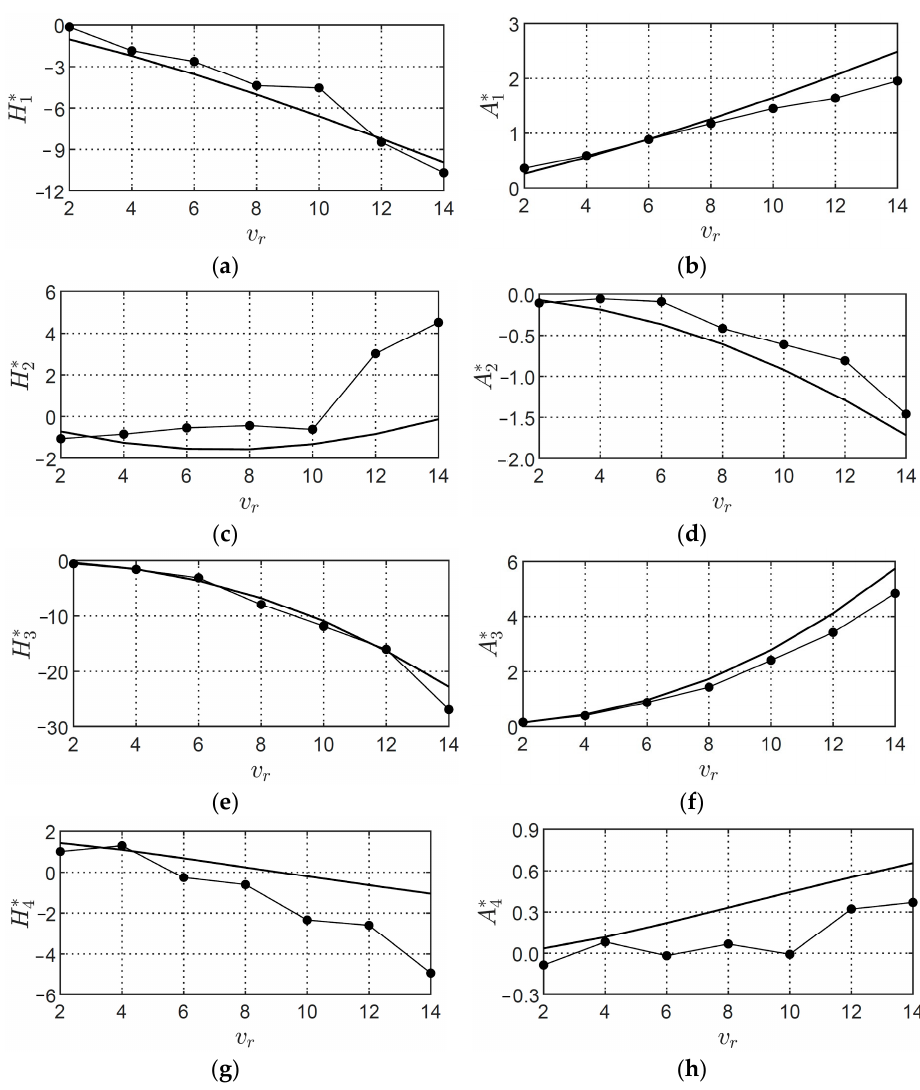
Figure 29. Aerodynamics derivatives from CFD simulation. ( ‒●‒ ) CFD forced vibration analysis, ( ― ) fl at plate by Theodorsen. ( a ) 𝐻 (cid:2869)∗ ; ( b ) 𝐴 (cid:2869)∗ ; ( c ) 𝐻 (cid:2870)∗ ; ( d ) 𝐴 (cid:2870)∗ ; ( e ) 𝐻 (cid:2871)∗ ; ( f ) 𝐴 (cid:2871)∗ ; ( g ) 𝐻 (cid:2872)∗ ; ( h ) 𝐴 (cid:2872)∗ .